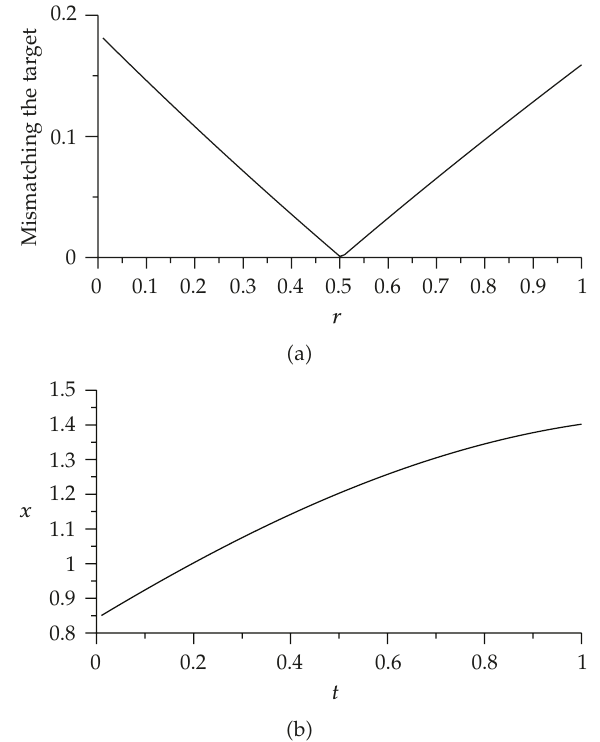
Figure 7: For example 6: (cid:3) a (cid:4) showing the error of mismatching, and (cid:3) b (cid:4) showing a numerical